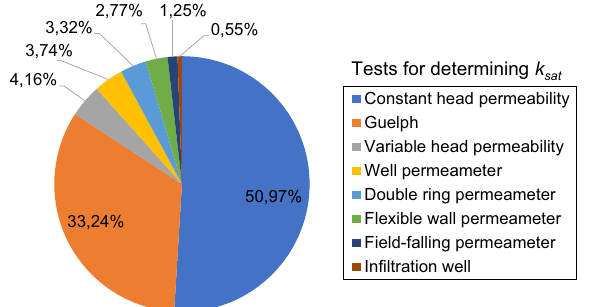
Figure 5. Distribution of the methods used in the collected data.